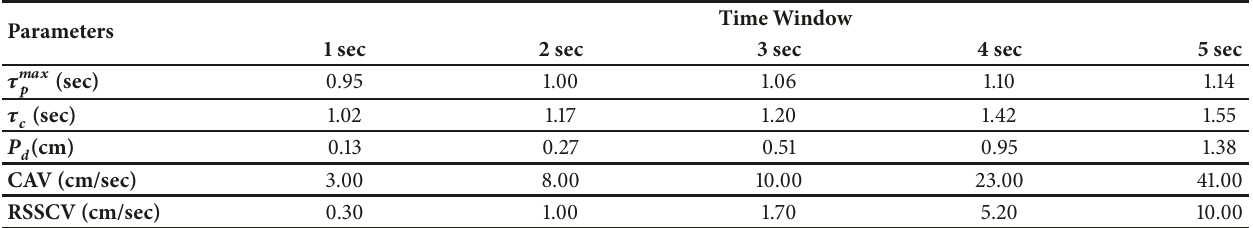
Table 1: Calculated threshold values of different EEW parameter for issuing warning for an event having M ≥ 6 at different time windows